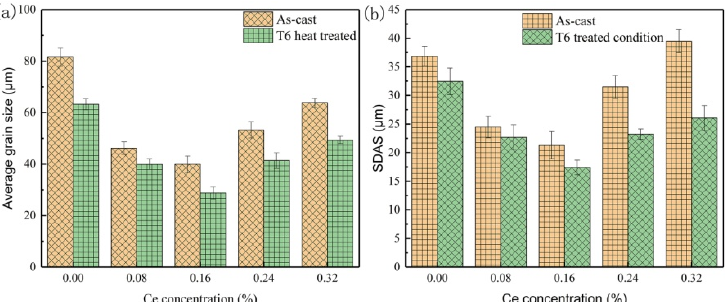
Figure 4. Statistical results of average grain size and secondary dendrite arm spacing (SDAS). ( a ) Grain size, ( b ) SDAS.